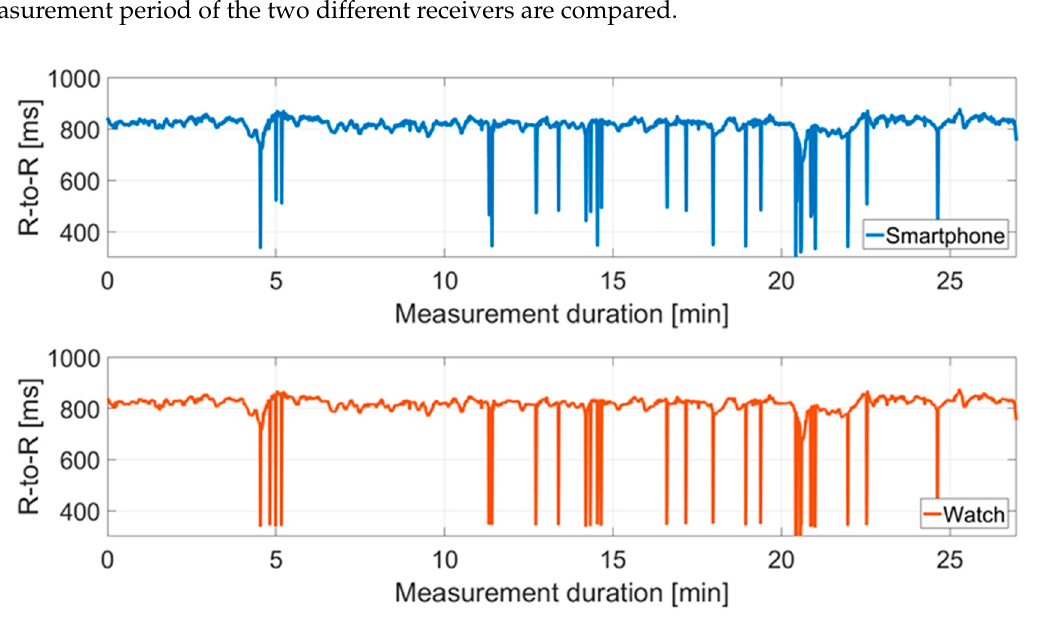
Figure 3. Exemplary comparison of RR interval (R-to-R) (ms) measurements prepared with mean vs. median over 60 s ( n = 72 measured values).